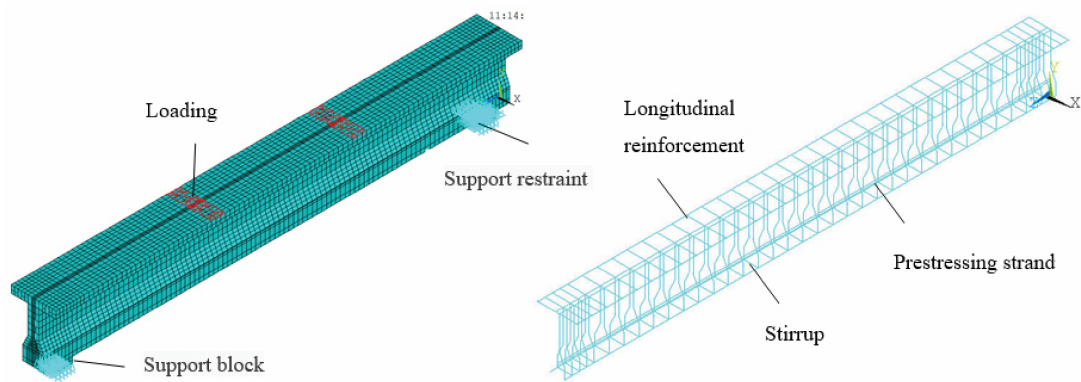
Figure 21. The finite element analysis model of prestressed concrete beam.